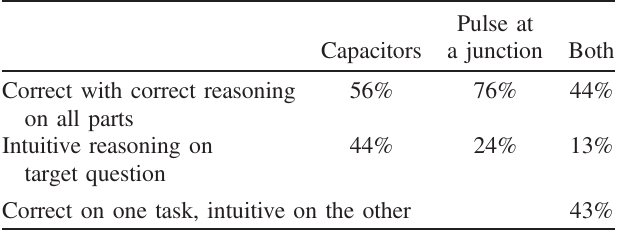
TABLE III. Patterns of reasoning on two question sequences: capacitors and pulse at a junction between two different springs. Only those students who demonstrated (on the screening ques- tions) that they possessed the formal knowledge necessary to answer these sequences correctly are considered ( N ¼ 63